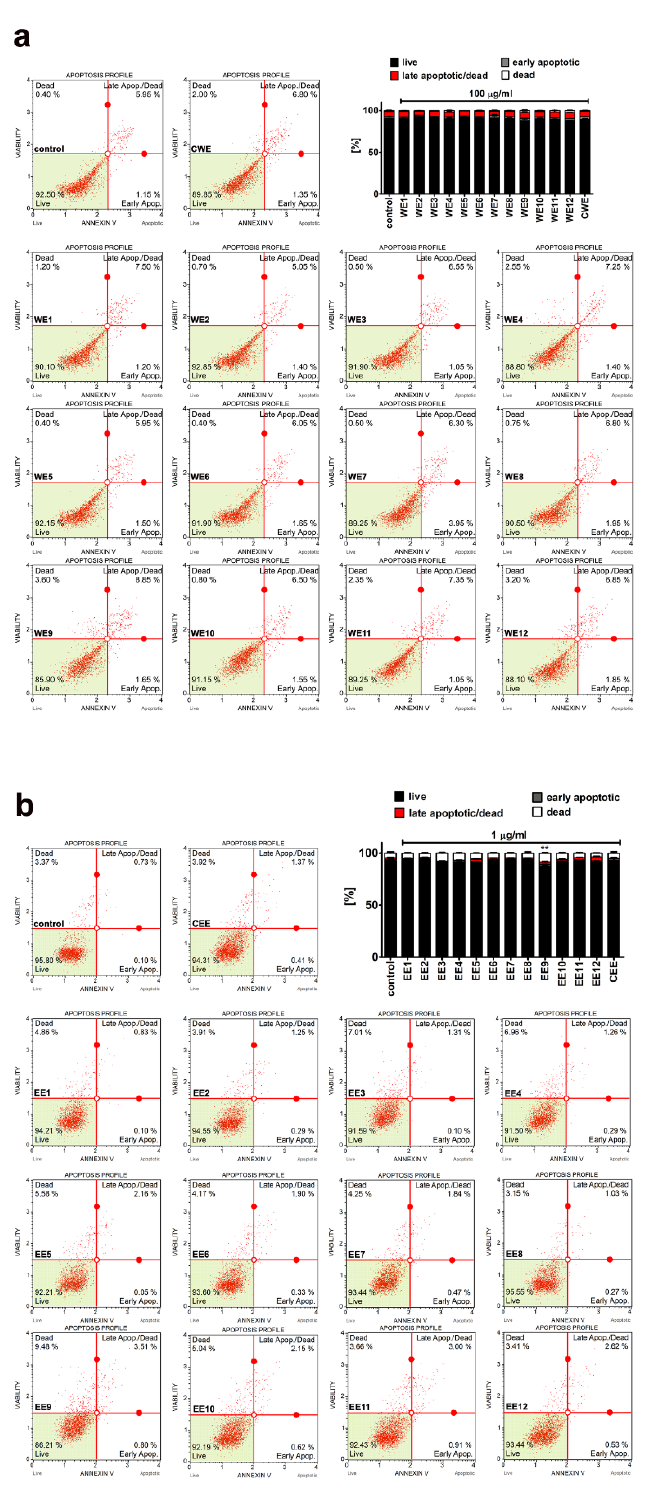
Figure 6. Extract-induced apoptosis in BJ cells (( a ) 100 µ g / mL water extracts) and HEK cells (( b ) 1 µ g / mL ethanolic extracts). ( a ) The e ff ects of water extracts (WE, twelve modified clones from WE1 to WE12) are shown. Control clone water extract is denoted as CWE. ( b ) The e ff ects of ethanolic extracts (EE, twelve modified clones from EE1 to EE12) are shown. Control clone ethanolic extract is denoted as CEE. Phosphatidylserine externalization was analyzed using a Muse ® Cell Analyzer and a Muse ® Annexin V and Dead Cell Assay Kit. Representative dot-plots are shown. Bars indicate SD, n = 3. ** p < 0.01 compared to the control (ANOVA and Dunnett’s a posteriori test).